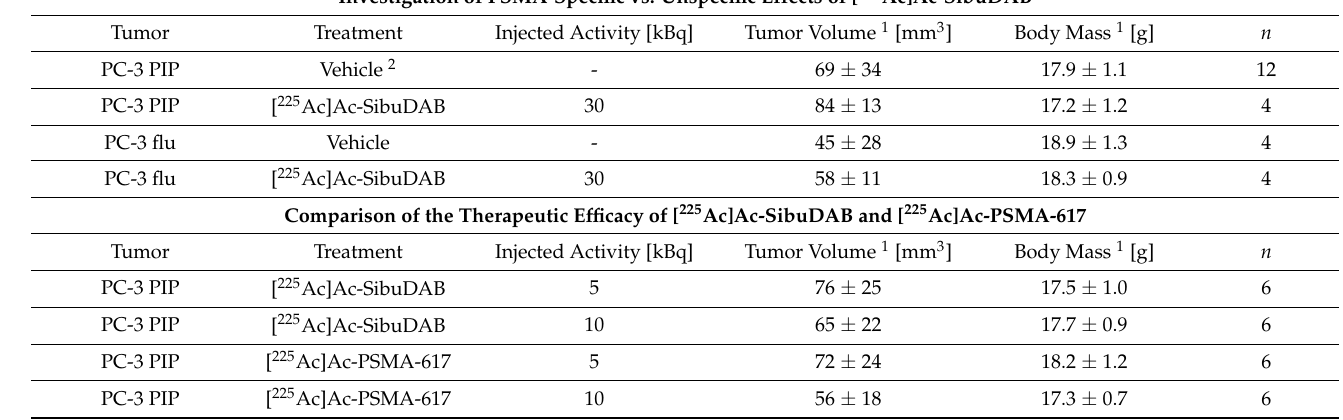
Table 1. Design of the therapy study including information about the number ( n ) of mice per group, the tumor type, the treatment, the injected activity and the average ± standard deviation (SD) of the tumor volume and body mass of mice of each group on Day